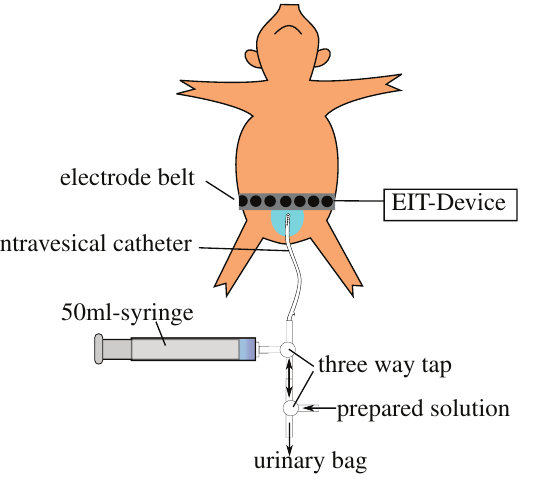
Fig.2: Experimental set-up of in-vivo measurement for controlled volume instillation: The EIT belt is placed cranial of the iliac crest and a standard urinary balloon catheter is used for fluid instillation by a 50ml syringe.